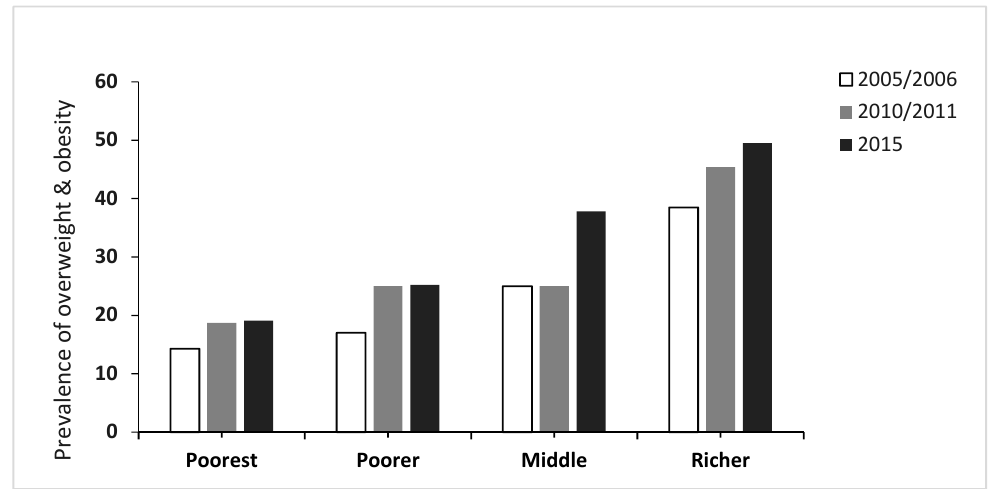
Figure 1. Prevalence of overweight and obesity by wealth index among women of reproductive age (15–49 years), Zimbabwe, 2005–2015.